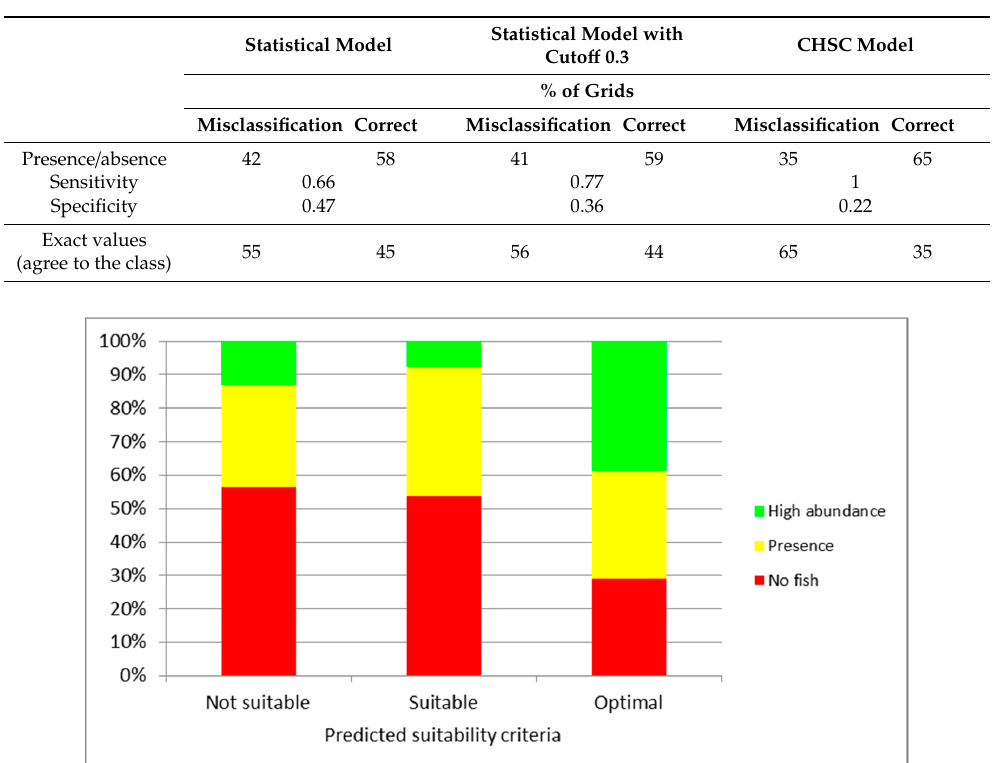
Figure 7. Comparison between results of the statistical model with a lower cutoff value and results of bullhead sampling in the Stura di Demonte. The x-axis shows predicted suitability criteria in three different classes: not suitable, suitable, and optimal. Fish presence is shown by colors.